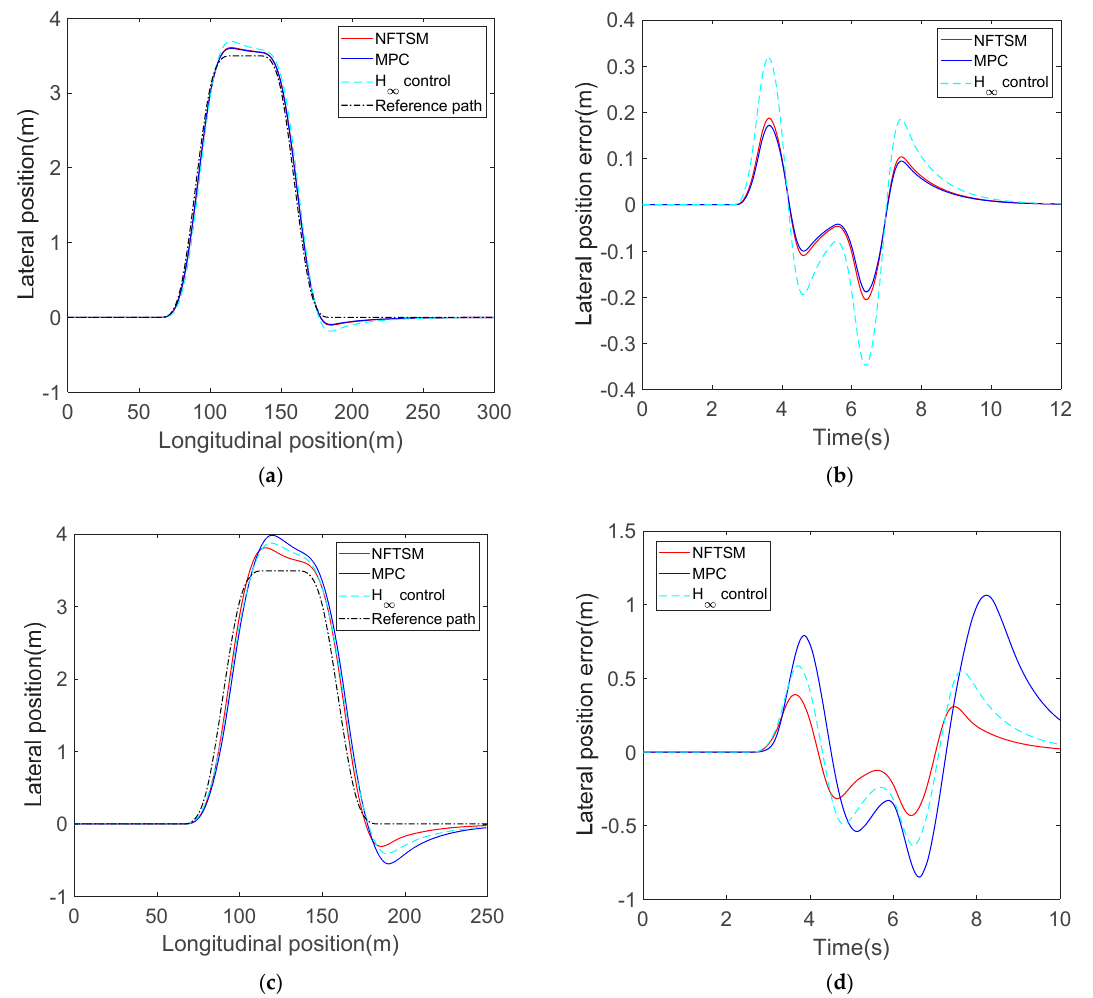
Figure 6. The comparison for three controllers: ( a ) Global vehicle trajectory with healthy system; ( b ) Lateral position error with healthy system; ( c ) Global vehicle trajectory with parameter perturba- tion; ( d ) Lateral position error with parameter perturbation.